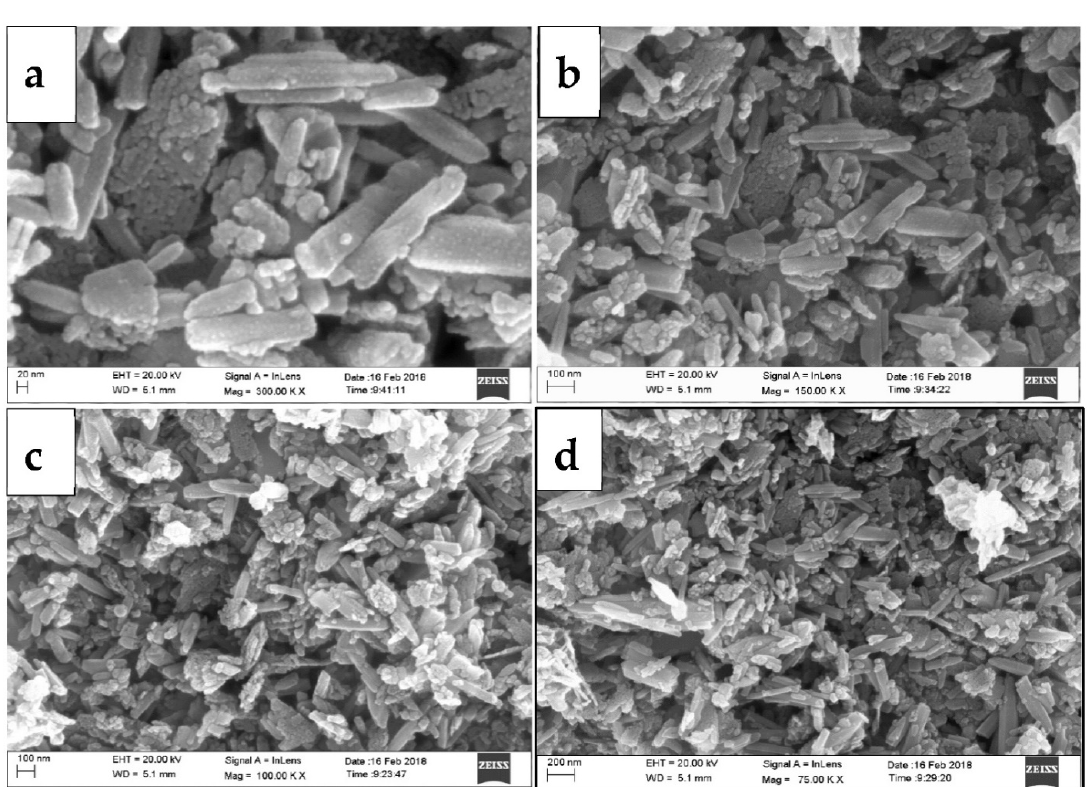
Figure 3. FESEM micrographs of ZnO NPs ( a – d ).